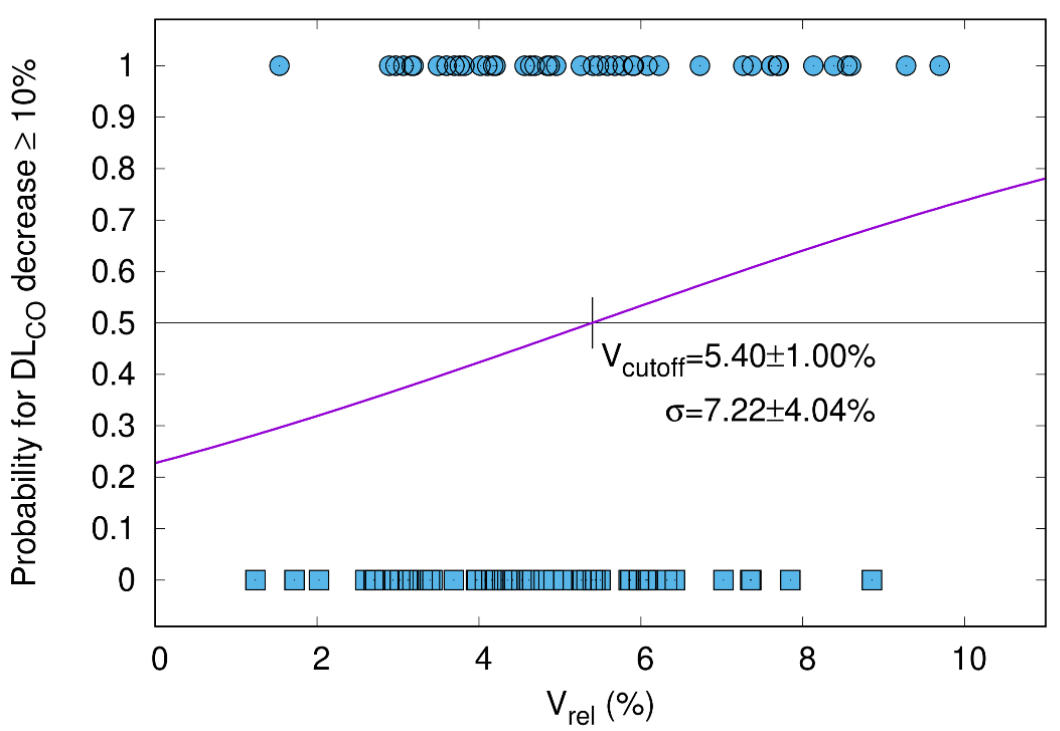
Figure 3. Whole cohort. The probability of DL CO decrease ≥ 10% after the end of RT (y-axis) is plotted as a function of the relative size of V 65–45% with respect to total lung volume (V rel , x-axis). The sigmoid shape of the cumulative distribution function (CDF) shows that a larger V 65–45% entails a higher probability for DL CO decline. All patients had paired measurements before and three months after radiotherapy ( n = 90; Pearson correlation coefficient = 0.143; p -value = 0.089). The cutoff for V rel was 5.4%. Patients with a DL CO decrease of ≥ 10% and < 10% are represented by circles and squares, respectively.